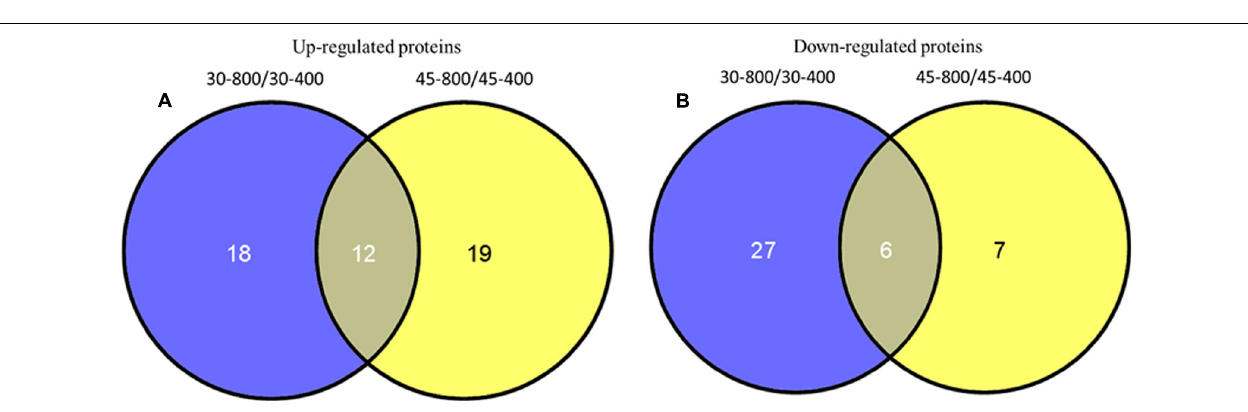
FIGURE 12 | Venn analysis of up-regulated proteins (A) and down-regulated proteins (B) identified in bermudagrass at 28 days of treatments. The treatments symbols are 30 and 45 for normal temperature control and heat stress and 400 and 800 for ambient CO 2 and elevated CO 2 concentrations,